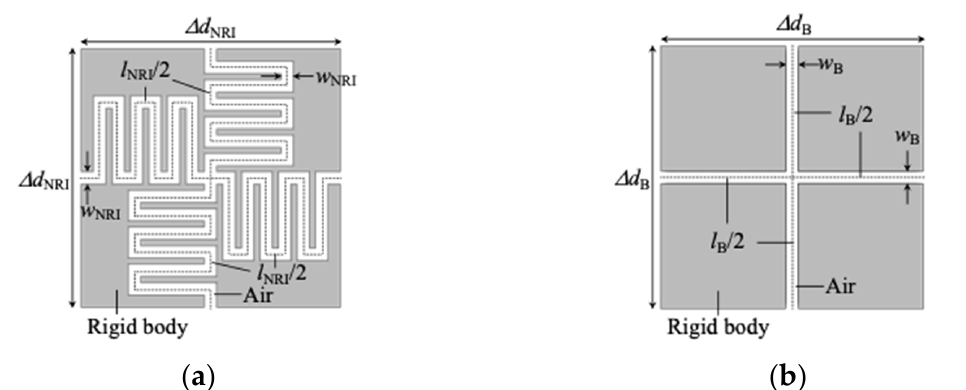
Figure 2. Unit cell structures. ( a ) Proposed meander acoustic waveguide unit cell structure for NRI acoustic metamaterials; ( b ) Straight acoustic waveguide unit cell structure for background media.